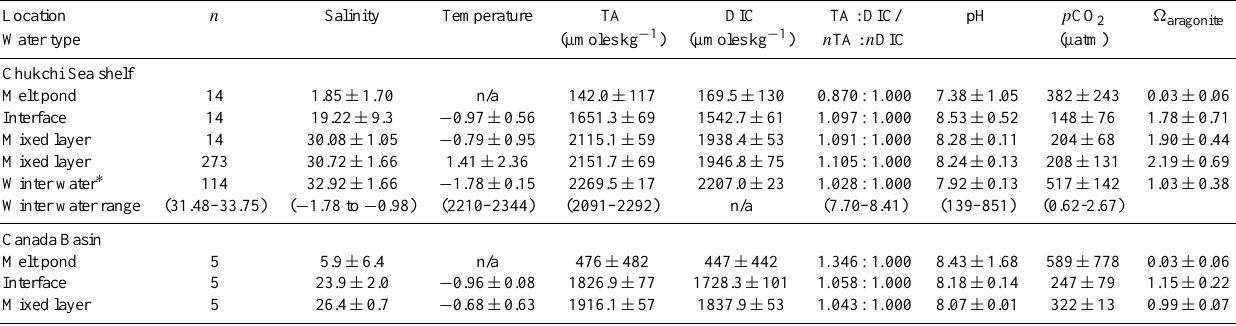
Table 2. Summary of mean above-ice and interface water hydrography and CO 2 –carbonate chemistry sampled at the sea-ice stations during the ICESCAPE expeditions in 2010 and 2011 with comparisons to the average mixed layer and remnant winter water conditions beneath the interface